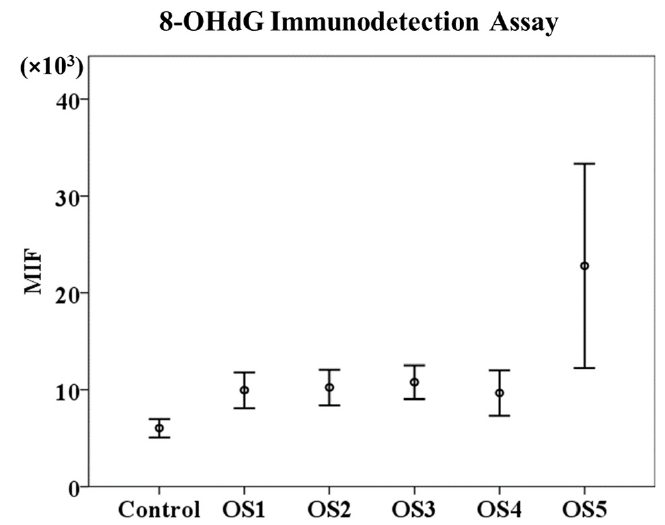
Figure 2. DNA oxidation quantification using an 8-OHdG immunodetection assay. Mean of Alexa Fluor 488 intensity of fluorescence ± standard error of the mean (MIF ± SEM) differences from 8- OHdG immunodetection assay. OS1 = 1 mM H 2 O 2 /0.1 µM FeSO 4 •7H 2 O; OS2 = 10 mM H 2 O 2 /1